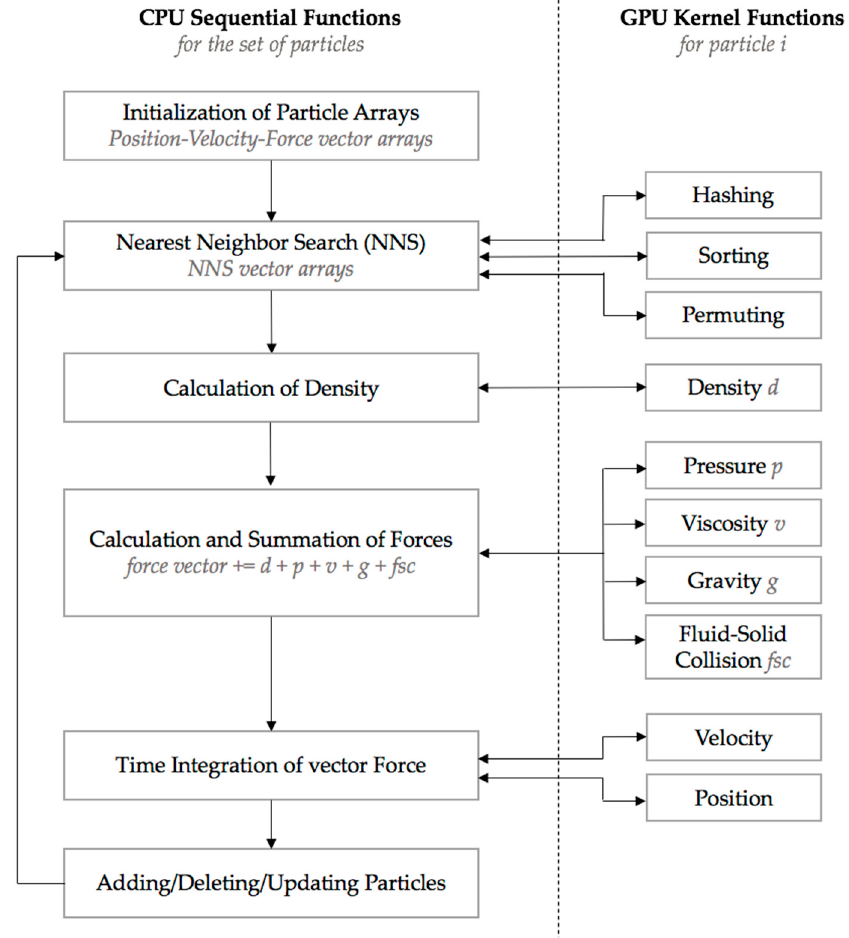
Figure 2. One time-step CPU-GPU implementation of smoothed particle hydrodynamics (SPH) fluid motion. To the left are the sequential tasks processed by the CPU. To the right are the parallel tasks (kernels) processed by the GPU.